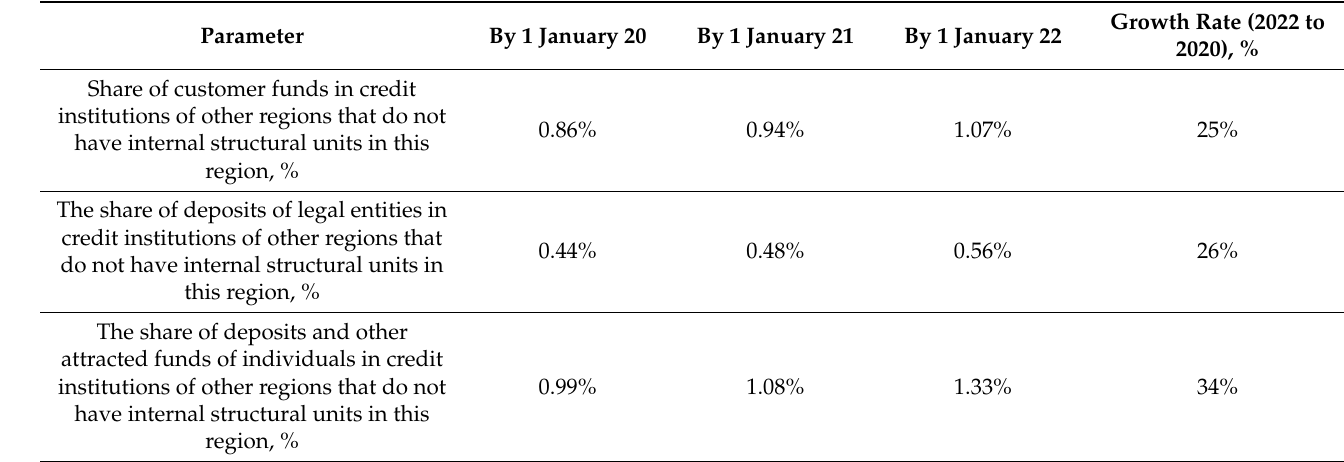
Table 3. The relative share of raised funds of legal entities and individuals, in credit institutions of other regions that do not have internal structural units in this region.